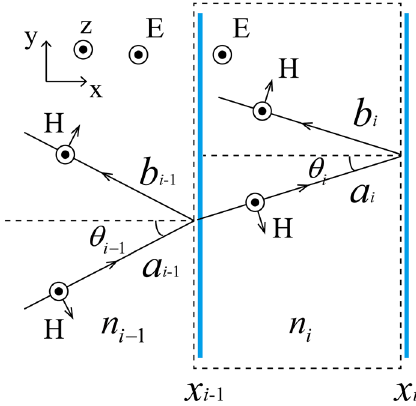
Figure 3: (Color online) The schematic of wave propagations for S -polarized